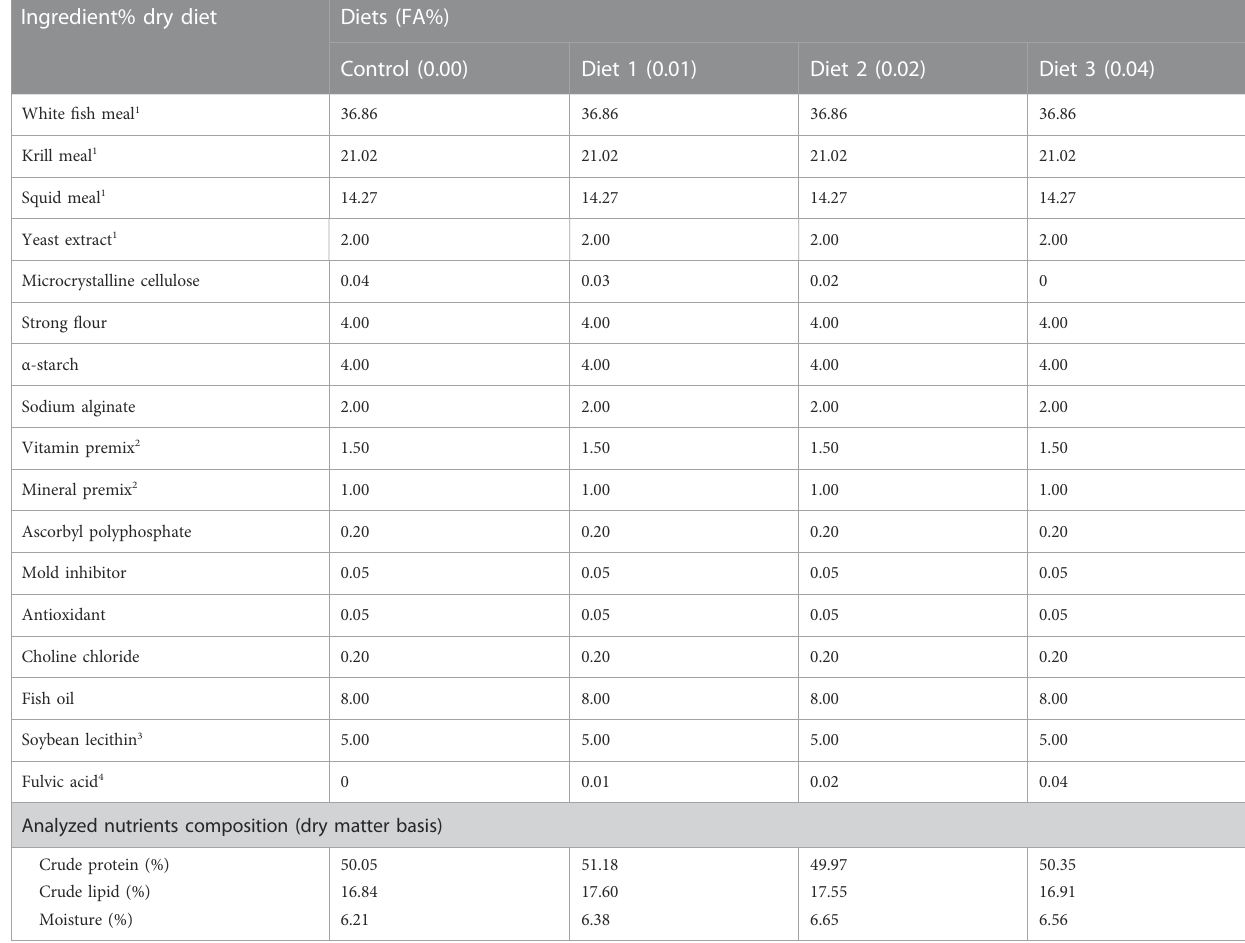
TABLE 1 Formulation and proximate composition of the experimental diets (% dry